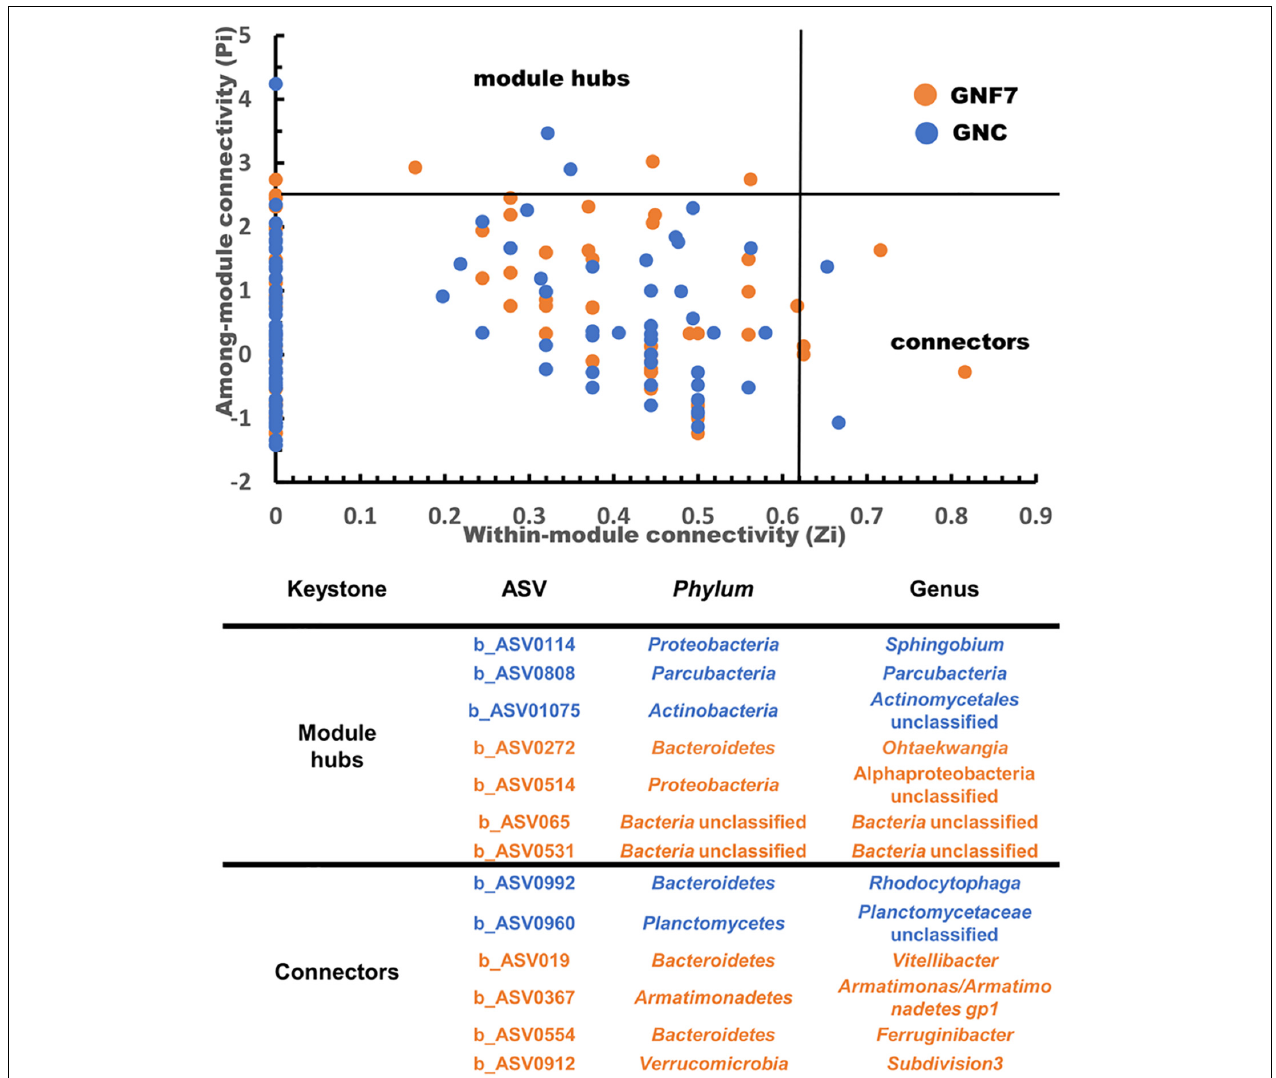
FIGURE 5 | ZiPi plots highlighting the keystone amplicon sequence variants (ASV) of the banana (cv. Grand Nain) root microbial network of control (GNC) and Pseudomanas simiae PICF7-inoculated (GNF7) plants. The module hubs have a Zi value > 2.5 and Pi value ≤ 0.62, and the connectors have a Zi value ≤ 2.5 and Pi > 0.62. The details of each keystone ASV are shown in the